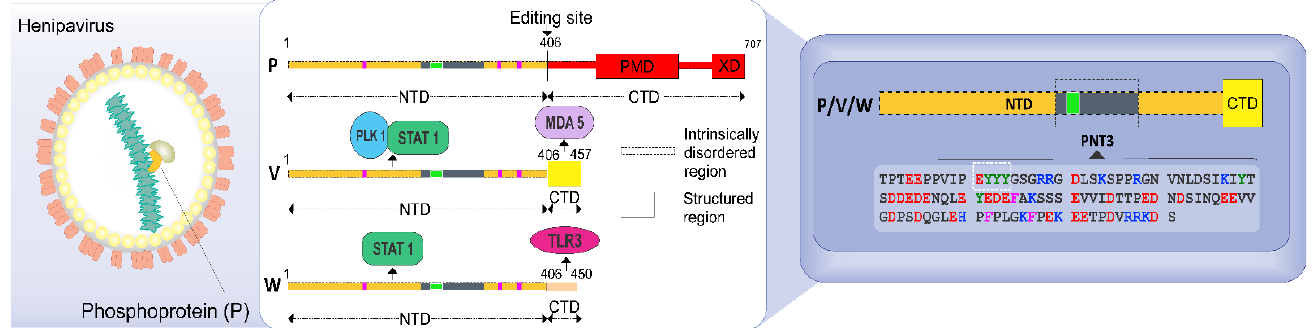
Figure 1. Schematic illustration of the HeV particle, of the organization of the P, V and W proteins and sequence of the HeV PNT3 region shared by the P, V, and W proteins. The left panel displays a scheme of the HeV virion, with the genome encapsidated by the nucleoprotein (in green) and the P (yellow) and the Large (wheat) proteins attached onto the nucleocapsid. The central panel displays a scheme of the P, V and W protein organization, showing that they share a common N-terminal domain (NTD) and have distinct C-terminal domains (CTD). PMD: P multimerization domain; XD: X domain of P. Interaction sites with proteins associated with the host innate immune response are shown. STAT: Signal Transducers and Activators of Transcription; PLK1: Polo-Like Kinase 1; MDA5: Melanoma Differentiation-Associated protein 5; TLR3: Toll-like receptor 3. Pink bars correspond to cysteine residues within NTD. The localization and the sequence of the PNT3 region within NTD is shown in grey and its sequence is displayed in the blue, right panel. The EYYY motif is shown as a green square and is framed within the PNT3 sequence.